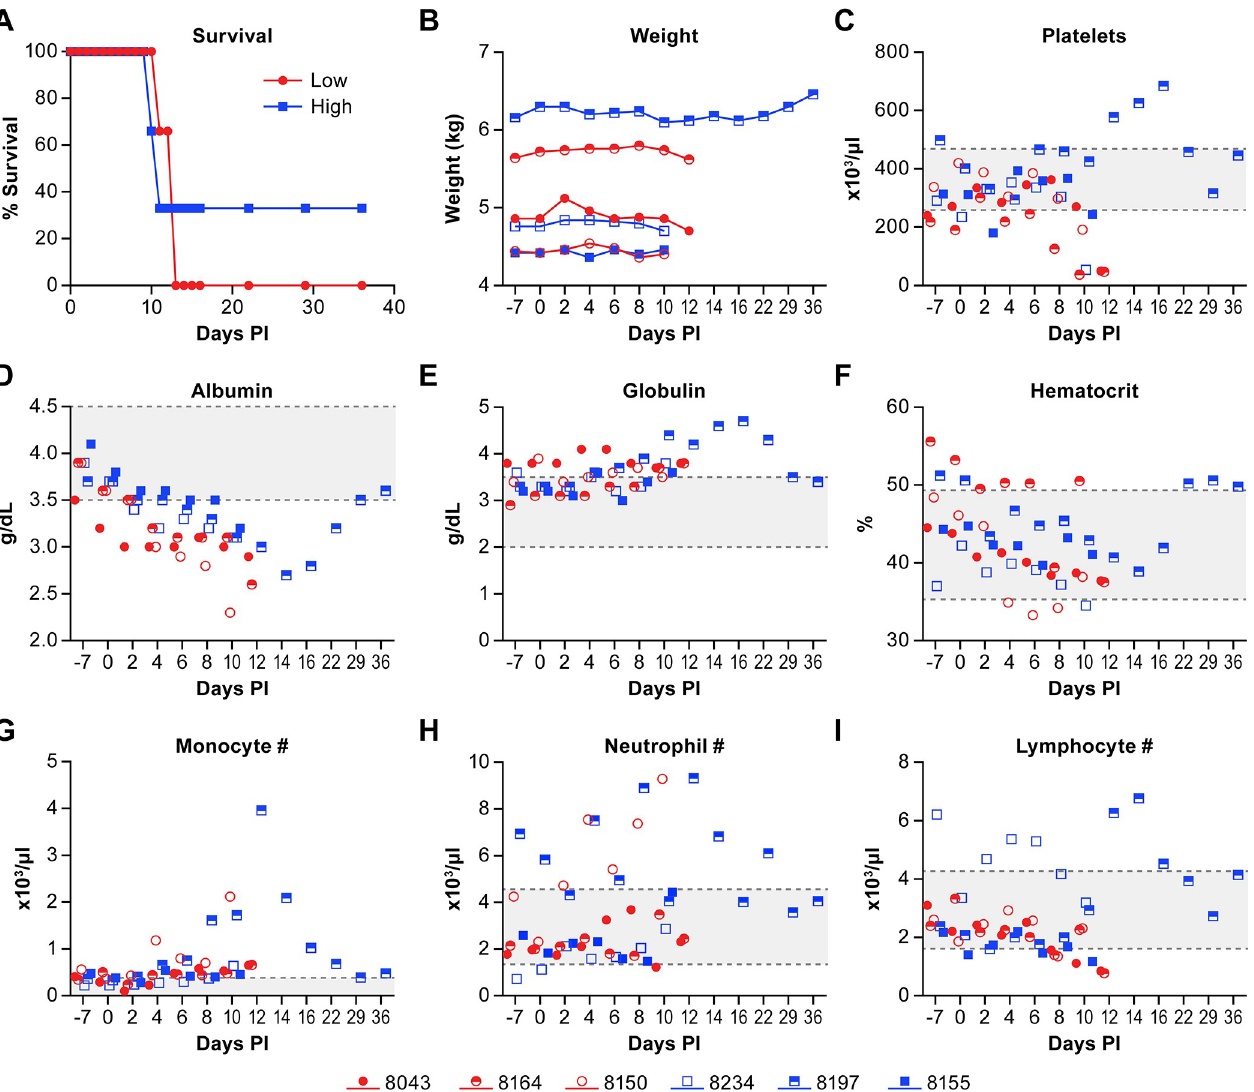
Fig 1. Clinical parameters of NiV infection. Clinical and hematological comparisons between the low (red circles) and high (blue squares) dose groups and individual animals. The color scheme and symbols used in this figure are consistent throughout the study for each individual animal. Animals were evaluated daily for clinical changes in well-being and bleed on alternate days through day 16 post-exposure for weight, chem-13 and CBC analyses. Data are presented here for (A) Survival; (B) Weight; (C) Platelets; (D) Albumin; (E) Globulin; (F) Hematocrit; (G) Number of monocytes per μ l; (H) Number of neutrophils per μ l; (I) Number of lymphocytes per μ l. The gray area between the dashed lines in panels C-I represent the range of average values for Caribbean origin AGMs [40].